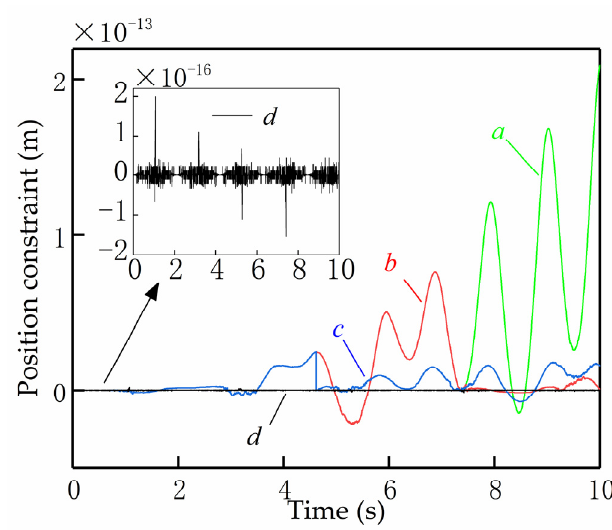
Figure 5. The violation of position constraint in the y-direction.